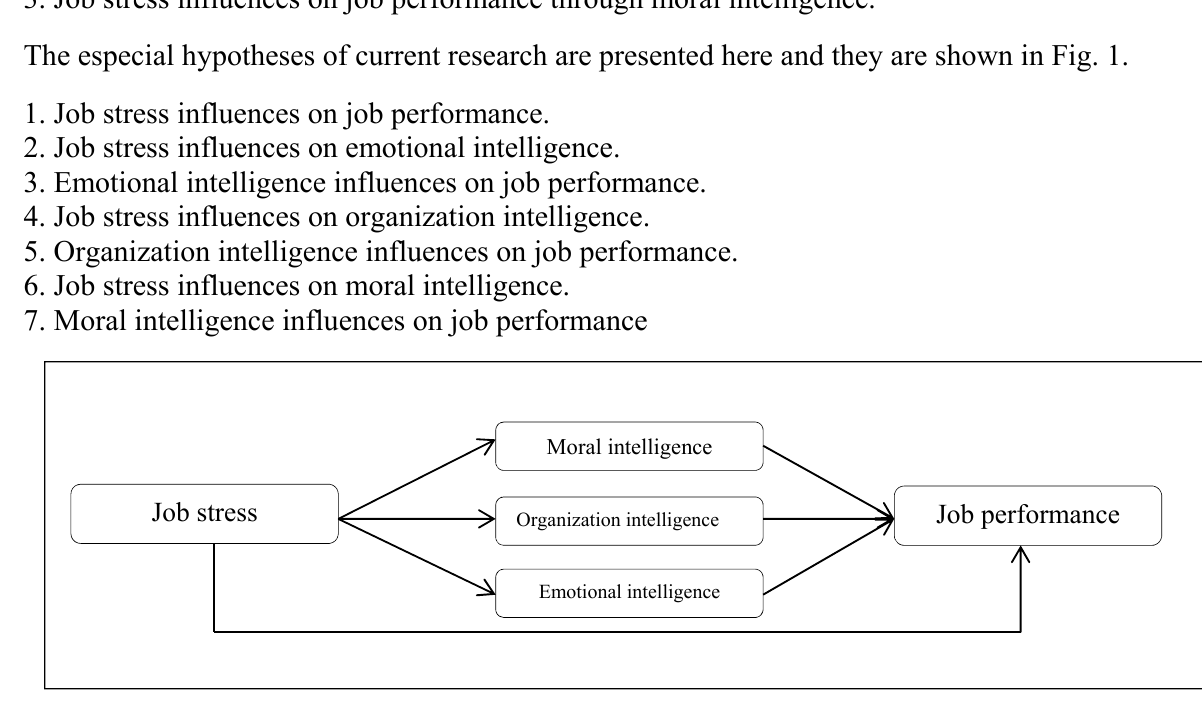
Fig. 1. The proposed study